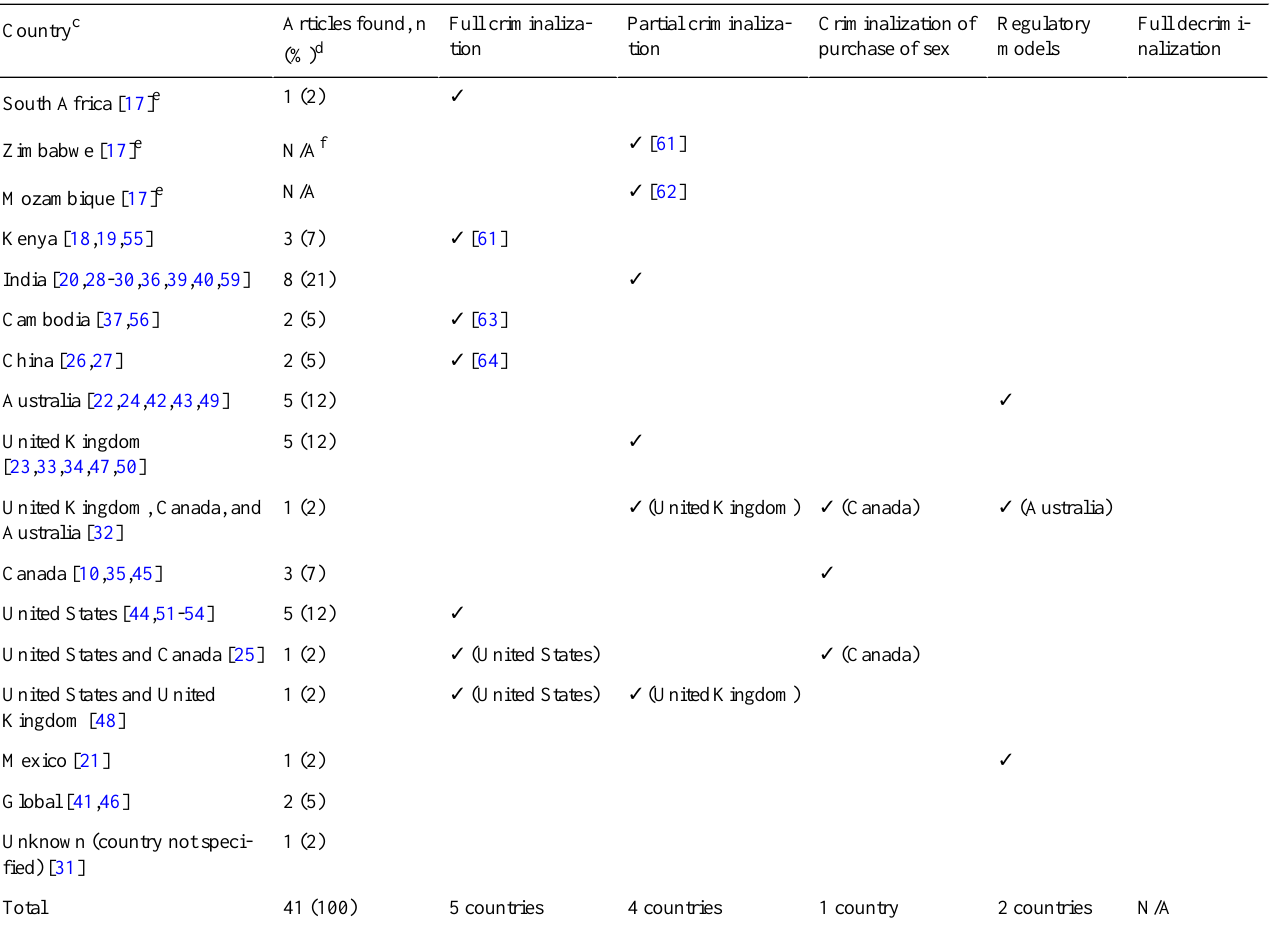
Table 2. Legislative models a,b . Country